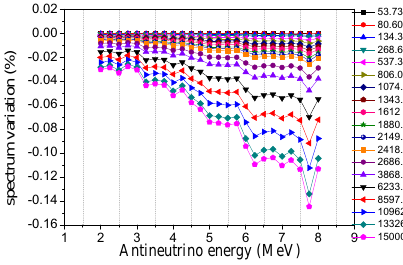
Figure 1. Fission fraction of the four isotopes vs fuel burnup